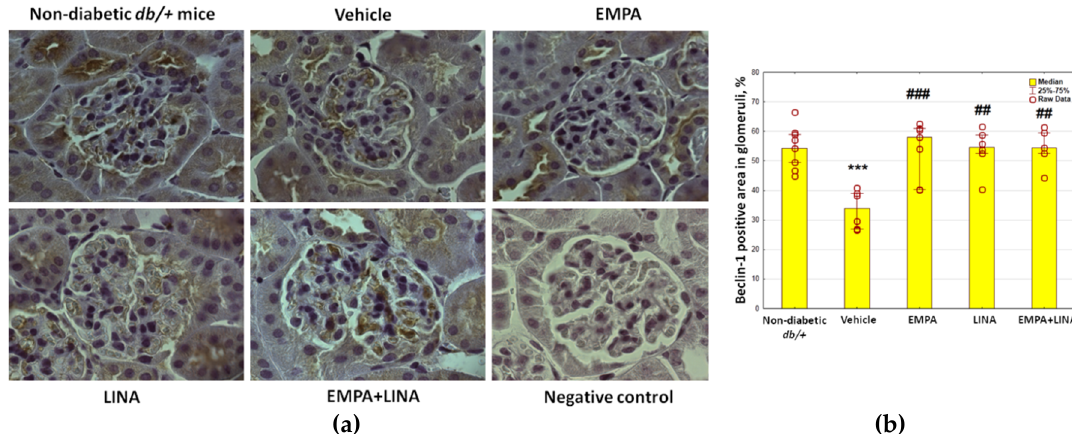
Figure 5. Glomerular beclin-1 expression in non-diabetic db /+ mice and diabetic db / db mice. ( a ) IHC-pictures of glomeruli of non-diabetic db /+ mice and db / db mice treated by vehicle, empagliflozin, linagliptin, or empagliflozin–linagliptin; magnification × 400; (b) Quantitative analysis of beclin-1-positive area in glomeruli. Data are presented as a bar graph (median, lower and upper quartile) with individual data set (dots); *** p < 0.001 vs. non-diabetic db /+ mice; ## p < 0.01, ### p < 0.001 vs. vehicle-treated db / db mice (Mann–Whitney U -test).